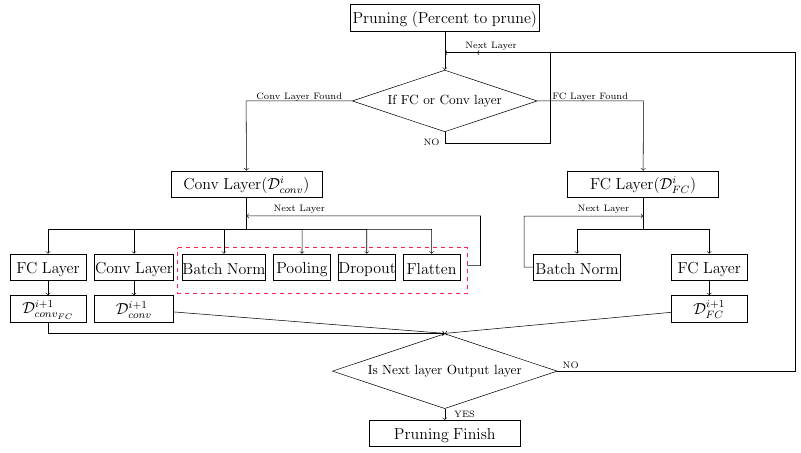
Figure 7. Flow chart for the pruning